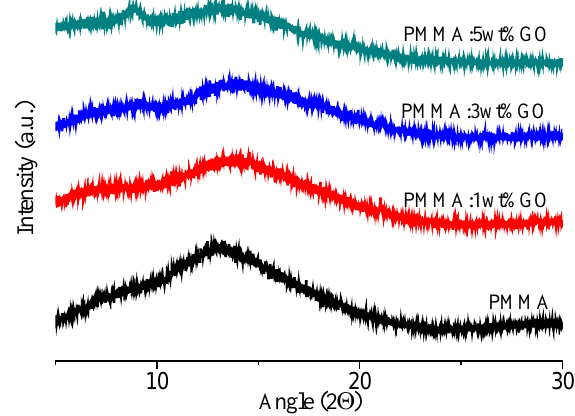
Figure 4. XRD patterns of PMMA and its composites with 1 wt %, 3 wt %, and 5 wt% GO. wt %. Table 1. XRD results for PMMA and its nanocomposites.